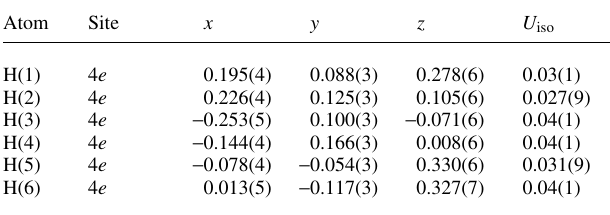
Table 7. Data collection and handling. Table 8. Atomic coordinates and displacement parameters (in Å 2 ) .